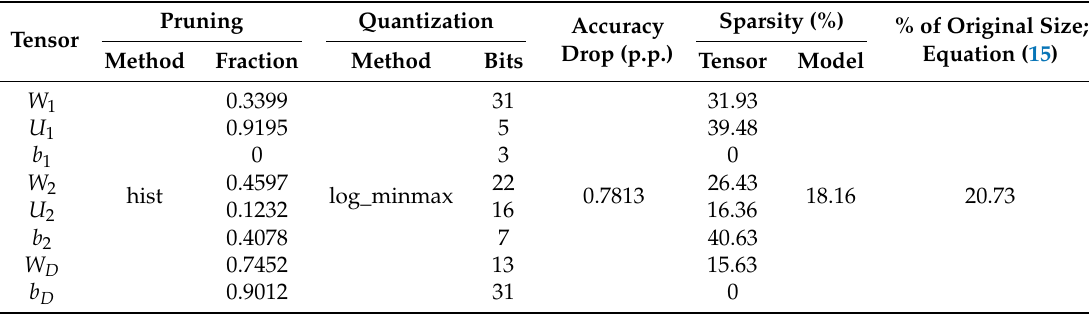
Table A7. [LHC] Results for model trained on continuous data with individualized pruning and quantization